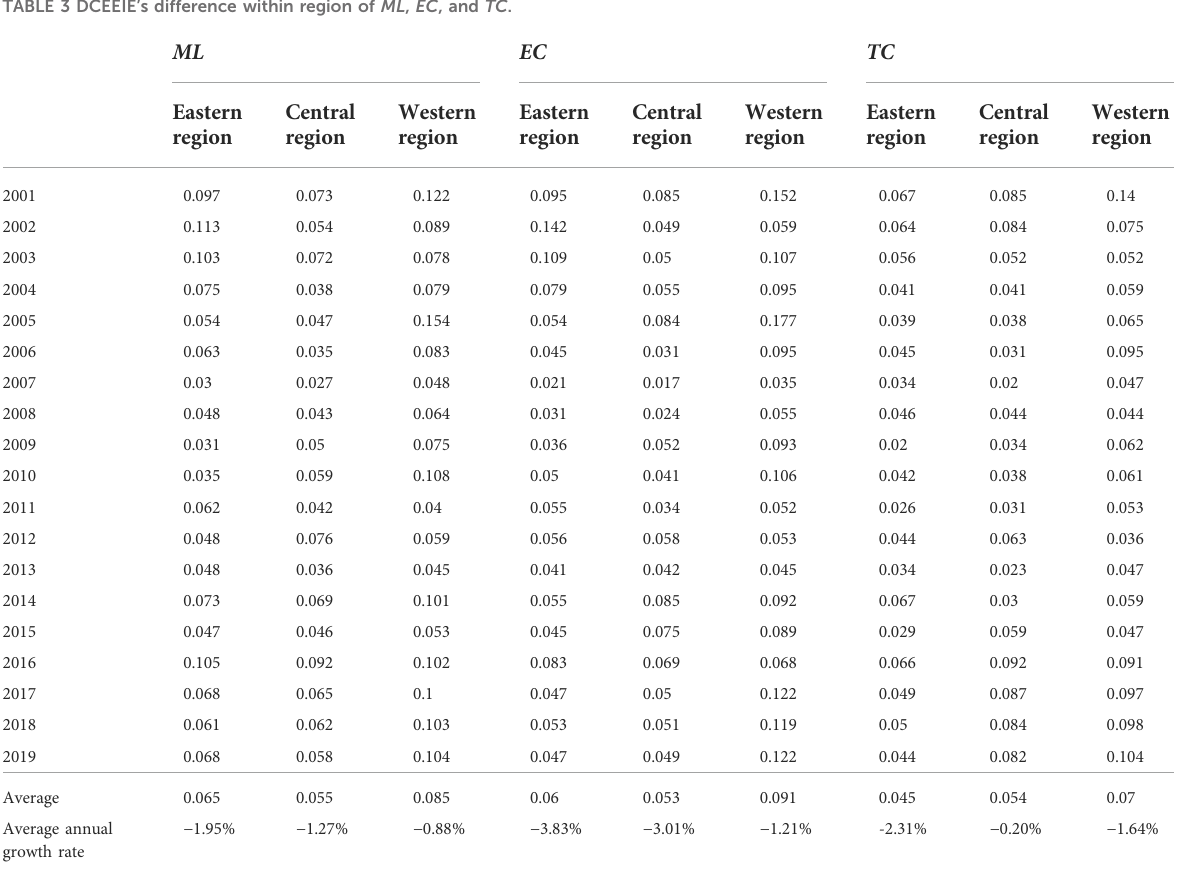
FIGURE 5 Total differences for ML , EC , and TC .